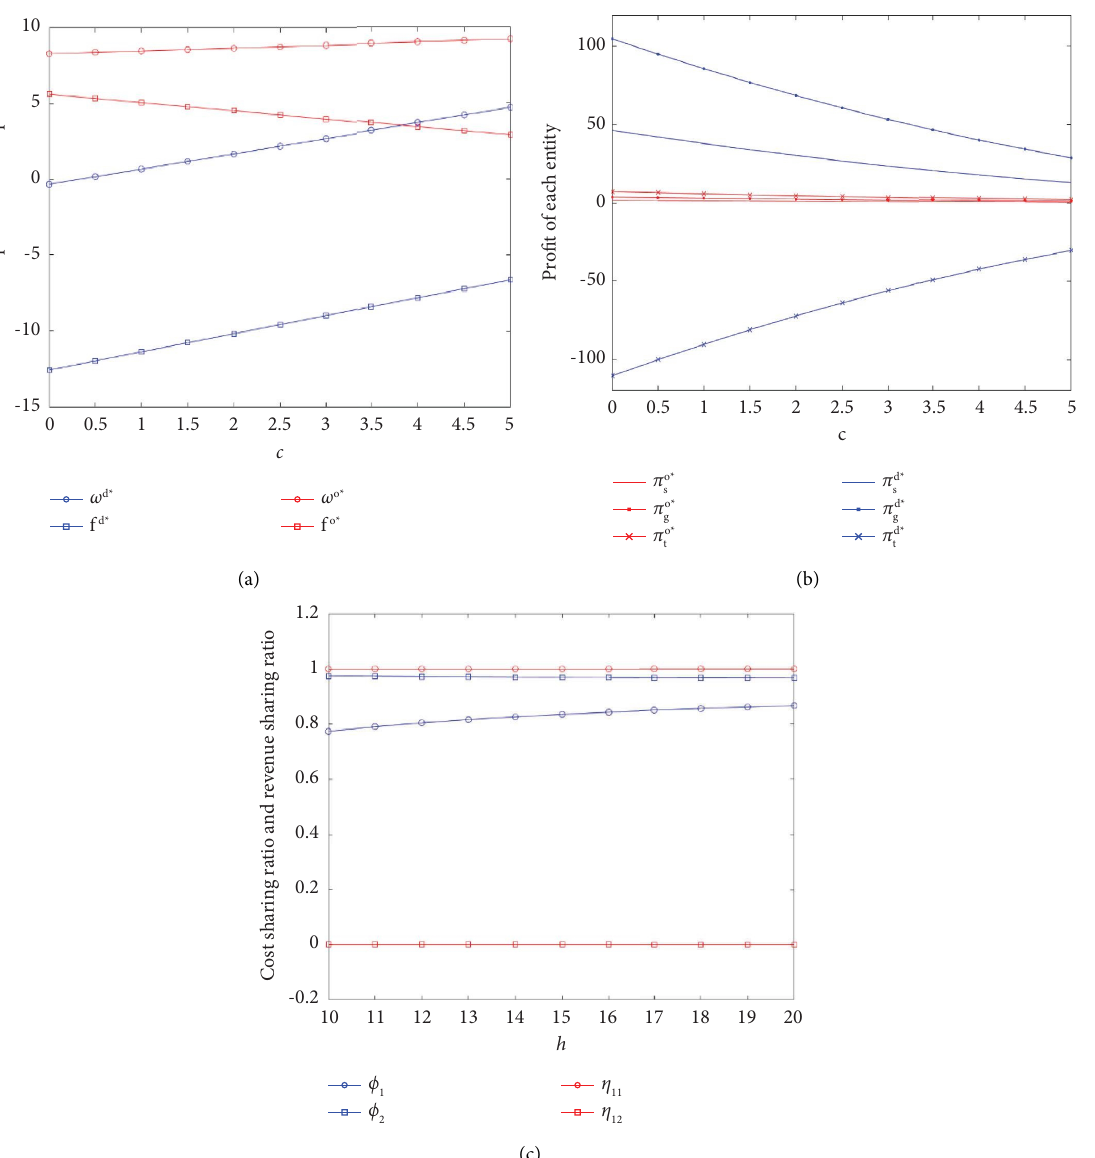
Figure 4: “Revenue sharing +double cost sharing” contract change trend and its impact on